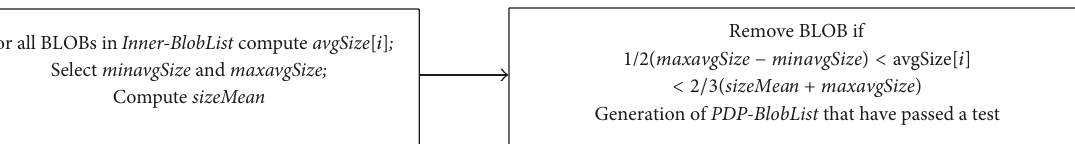
For all BLOBs in Inner-BlobList compute avgSize [ i ] ;